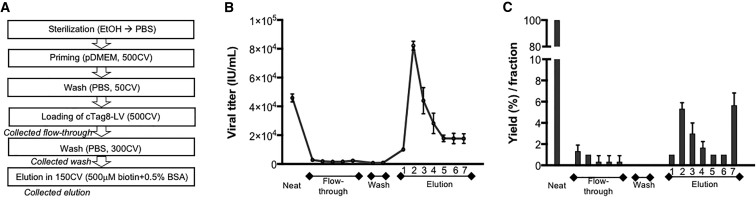
Affinity Chromatography Purification of cTag8 LVs Using Streptavidin Monolith Column(A) Diagram of the CIMac streptavidin (0.1-mL) analytical column purification step process, with indicated collected fractions (5 × 10 mL flow-through fractions; 2 × 15 mL wash fractions; 6 × 1.5 mL [1 to 6], and 1 × 7.5 mL [7] eluate fractions), which were assessed for their viral titers by infectivity assay. (B) Viral titers of collected fractions, and (C) the yield of each fraction in terms of total transducing units (TU), which are represented as a percentage of starting input transducing units. Values are presented ± SD of triplicate determinations for each fraction.